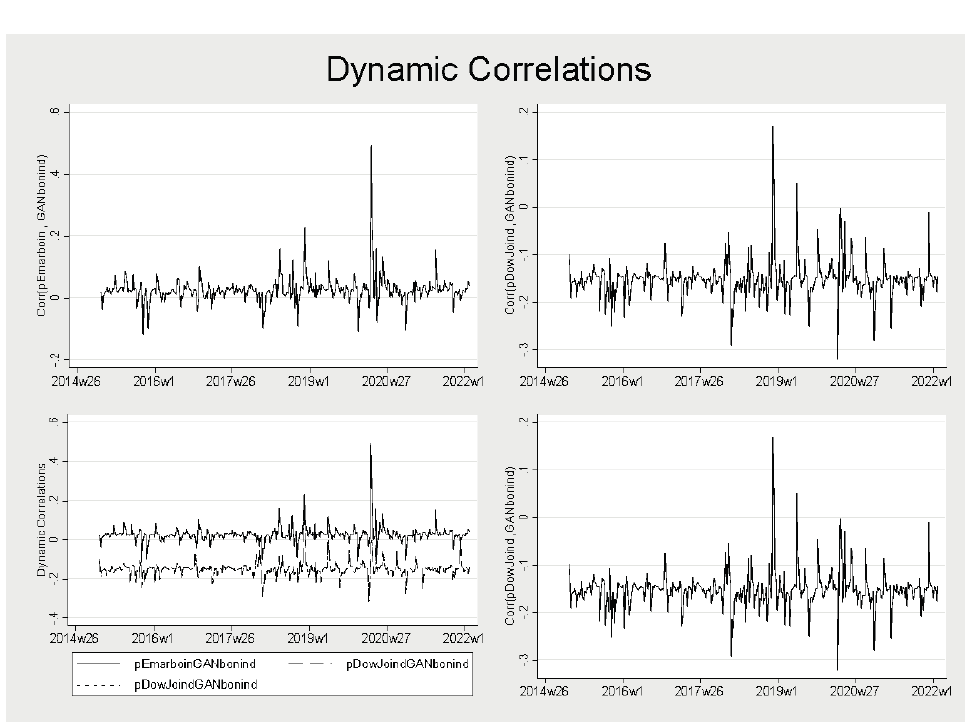
Fig. 1. DCC between exogenous variables and the sovereign bond return of Ghana.